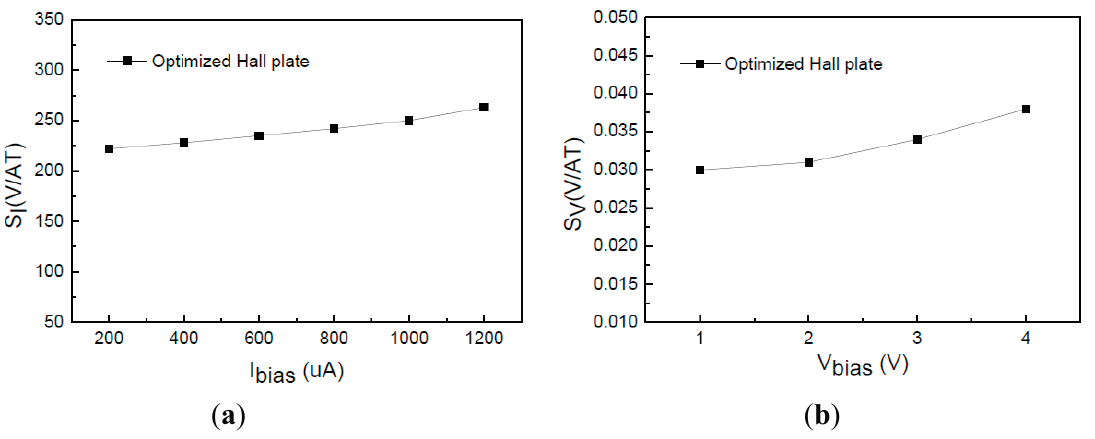
Figure 11. Tested magnetic sensitivity of cross-like Hall plate versus bias voltage or current.